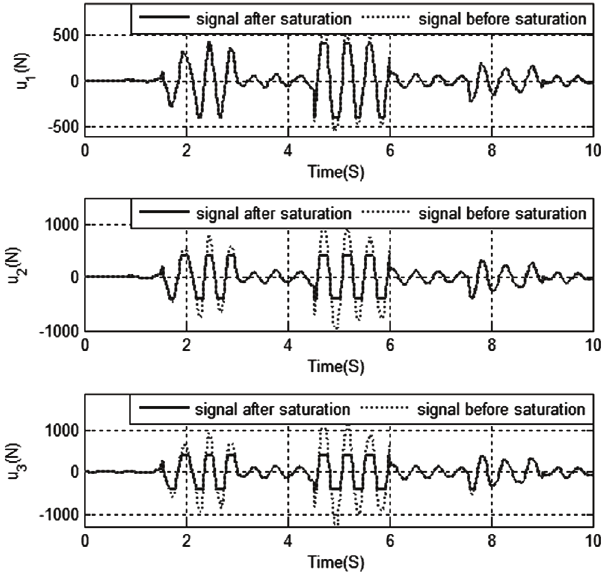
Fig. 14. Control forces in case B1 ( τ = 25